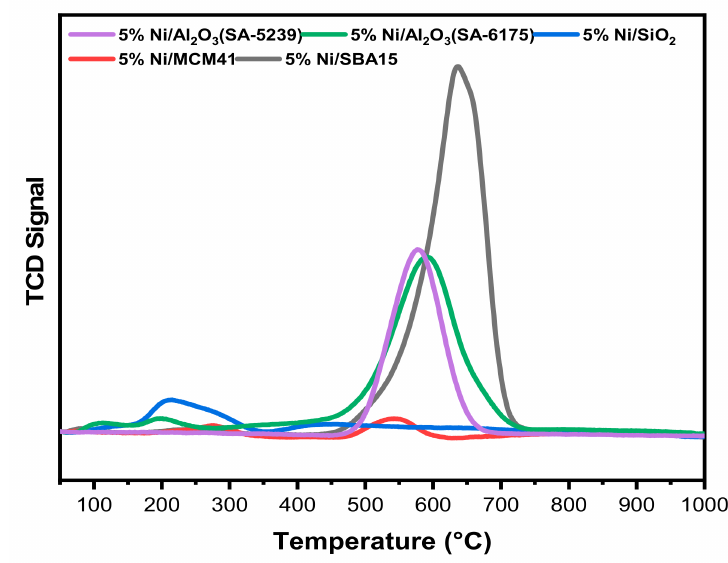
Figure 6. Temperature-Programmed Oxidation (TPO) profiles for all of the spent catalysts.